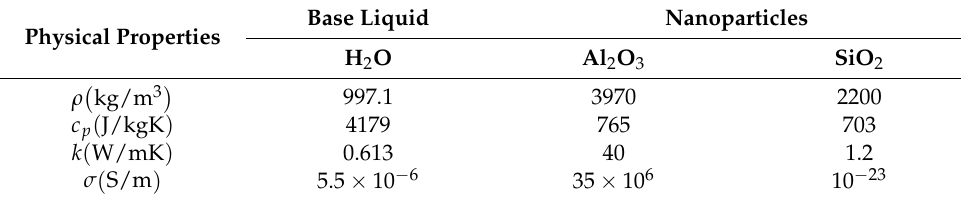
Table 1. Thermo-physical properties of the base fluid and different nanoparticles. Physical